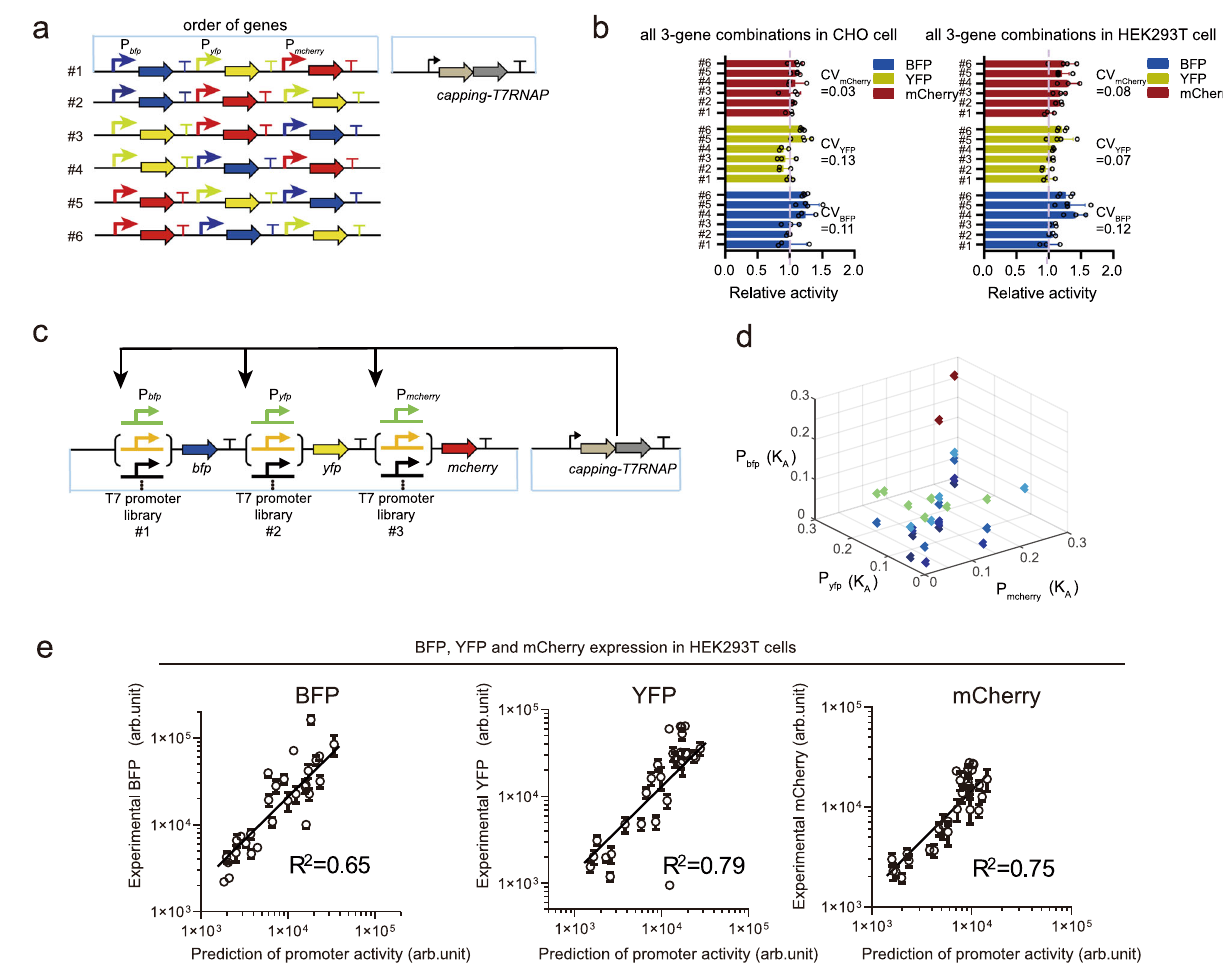
Fig. 3 | Gene-order effect for three-gene expression and predictions of the resource-competition model. a Schematic of the three-reporter characterization system with all possible orders of the transcriptional units. b Relative activity of blue, yellow and red fl uorescent proteins of each reporter gene ( bfp , yfp , and mCherry )basedontheirrespectiveexpressionlevelinconstruct#1.Datarepresent the mean±SD( n =4). c Schematic of the circuitfor the performance evaluation of